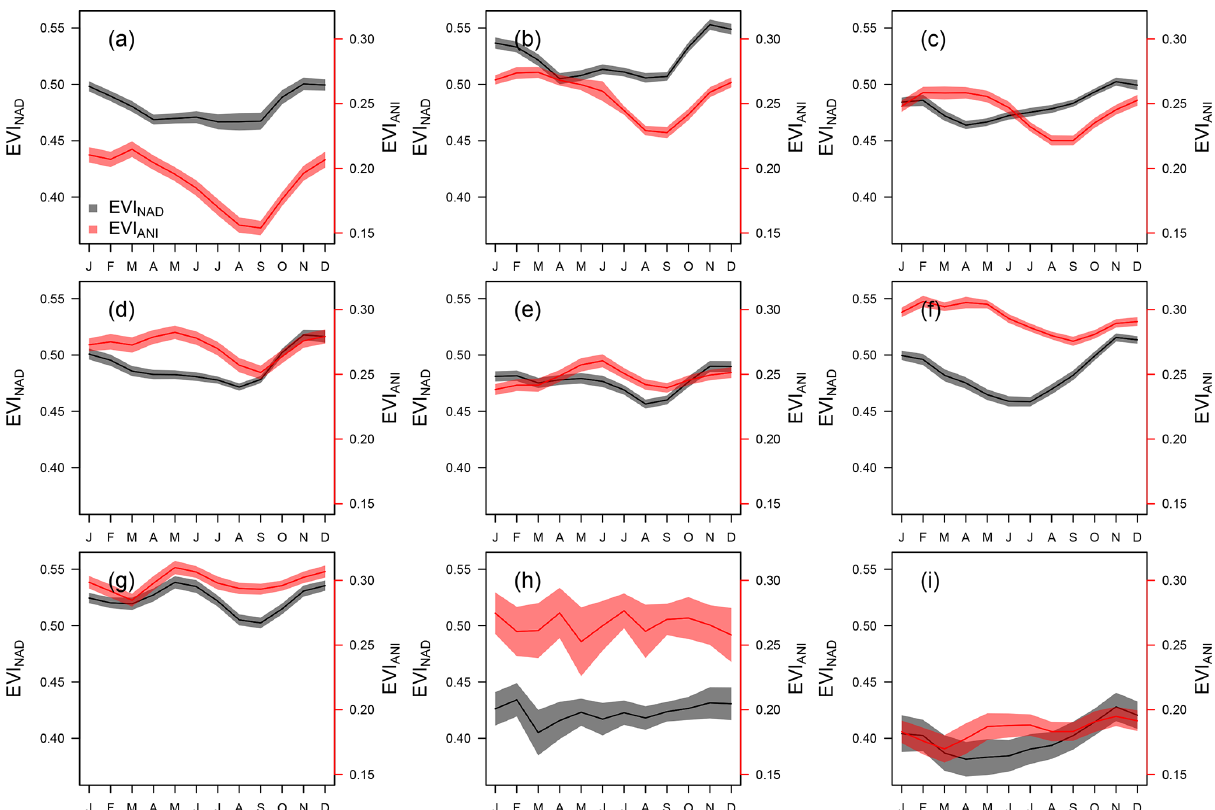
Figure 6. Monthly means of EVI NAD (black) and EVI ANI (red) for nine phenoregions mapped by Xu et al. (2015) in the Amazon. The phenoregions are shown in increasing order from 1 to 9 in corresponding panels (a) to (i) . They represent forests with similar seasonality and landscape structure. Solid lines and shaded areas represent the mean and 95% confidence interval around the mean. The values were extracted from 20 years of data (from 2001 to 2021) for 100 random coordinates within each region and extracted from 3 × 3 windows of pixels.